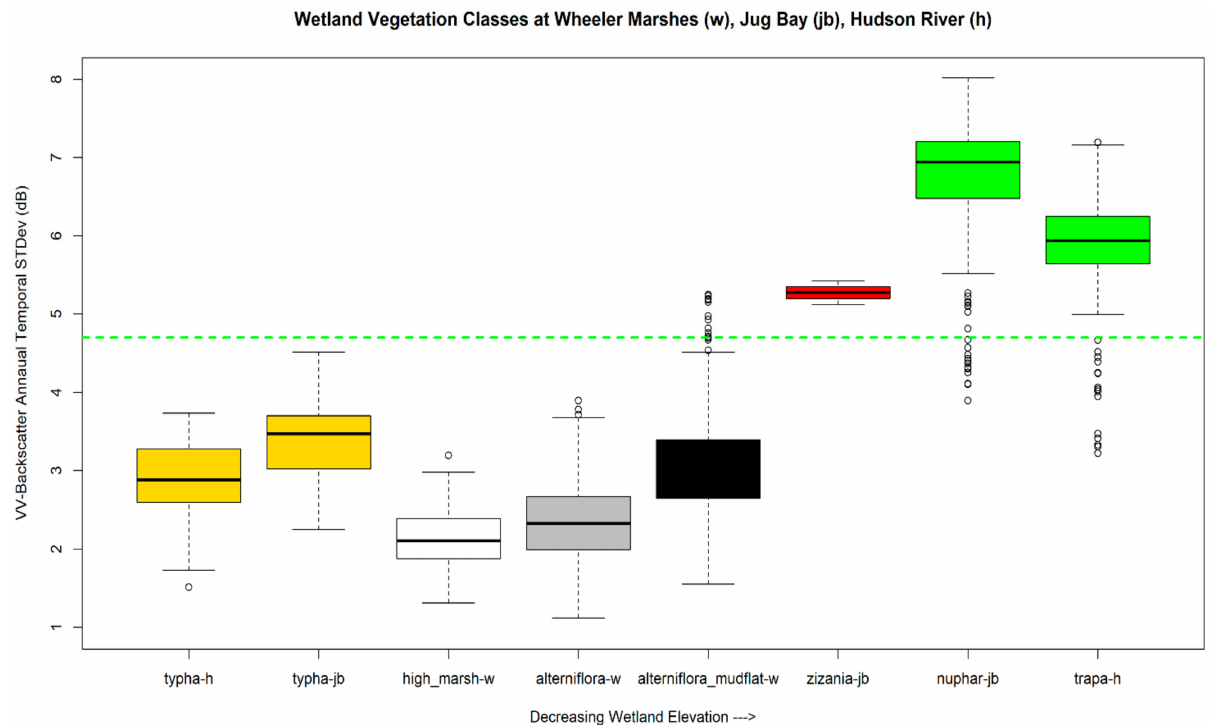
Figure 9. 2017 Sentinel-1 VV annual standard deviation (VV-SD) pixel values by wetland vegetation class at Wheeler Marshes (w), Jug Bay (jb), and Hudson River (h) sites. For box labels, the first term represents wetland vegetation type and the second term is the location (e.g., “typha-h” is Typha spp. from Constitution Marsh in the Hudson River). All boxes represent VV-SD extraction for the wetland vegetation boundaries/polygons shown in Figure 2 that were also used for time-series spatial mean backscatter computation in Figures 6–8. Note that colors also correspond to vegetation type in Figures 6–8, except for Wheeler Marsh where grayscale box colors represent elevation gradient. Note threshold of 4.7 dB threshold separates persistent and non-persistent vegetation (horizontal dashed green